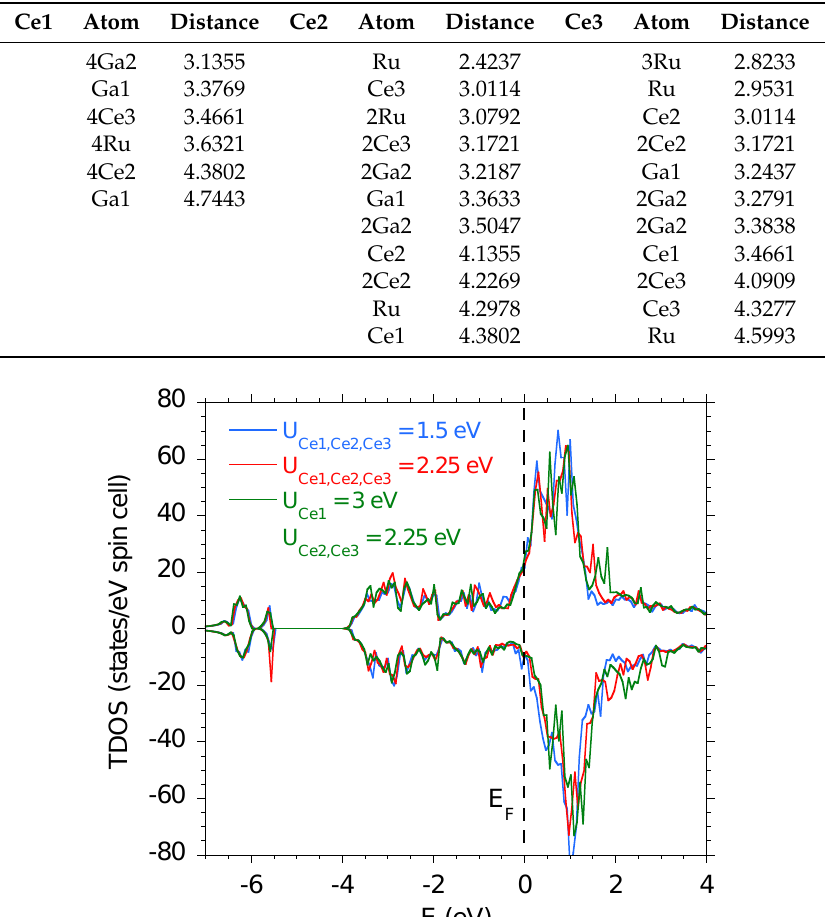
Table 2. Interatomic distances (Å) in the crystal structure of Ce 9 Ru 4 Ga 5 .